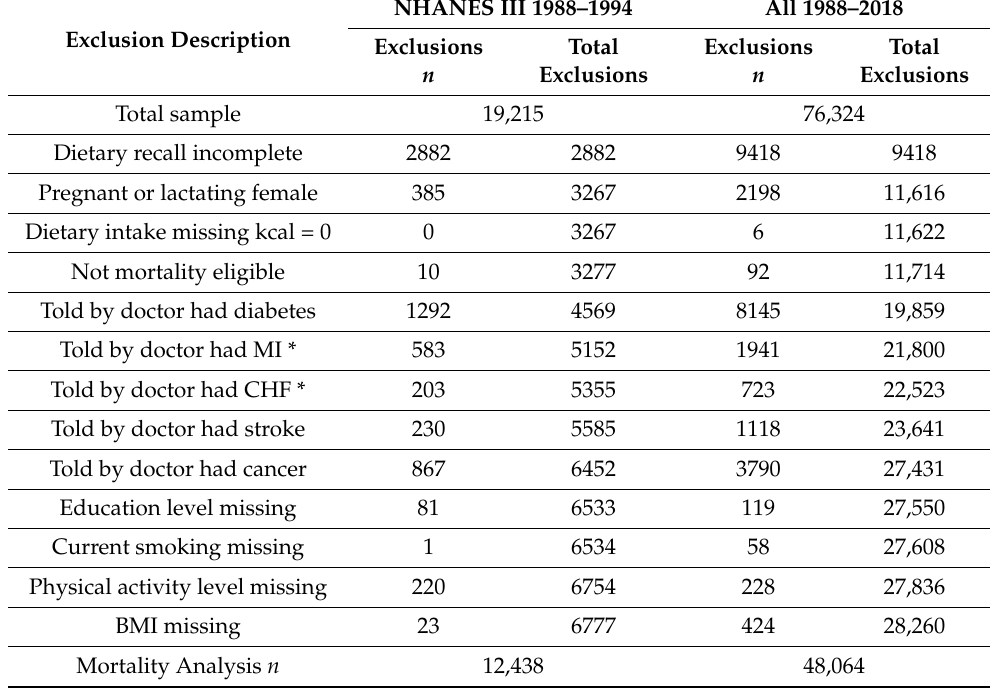
Table 1. Hazard ratio analyses exclusions